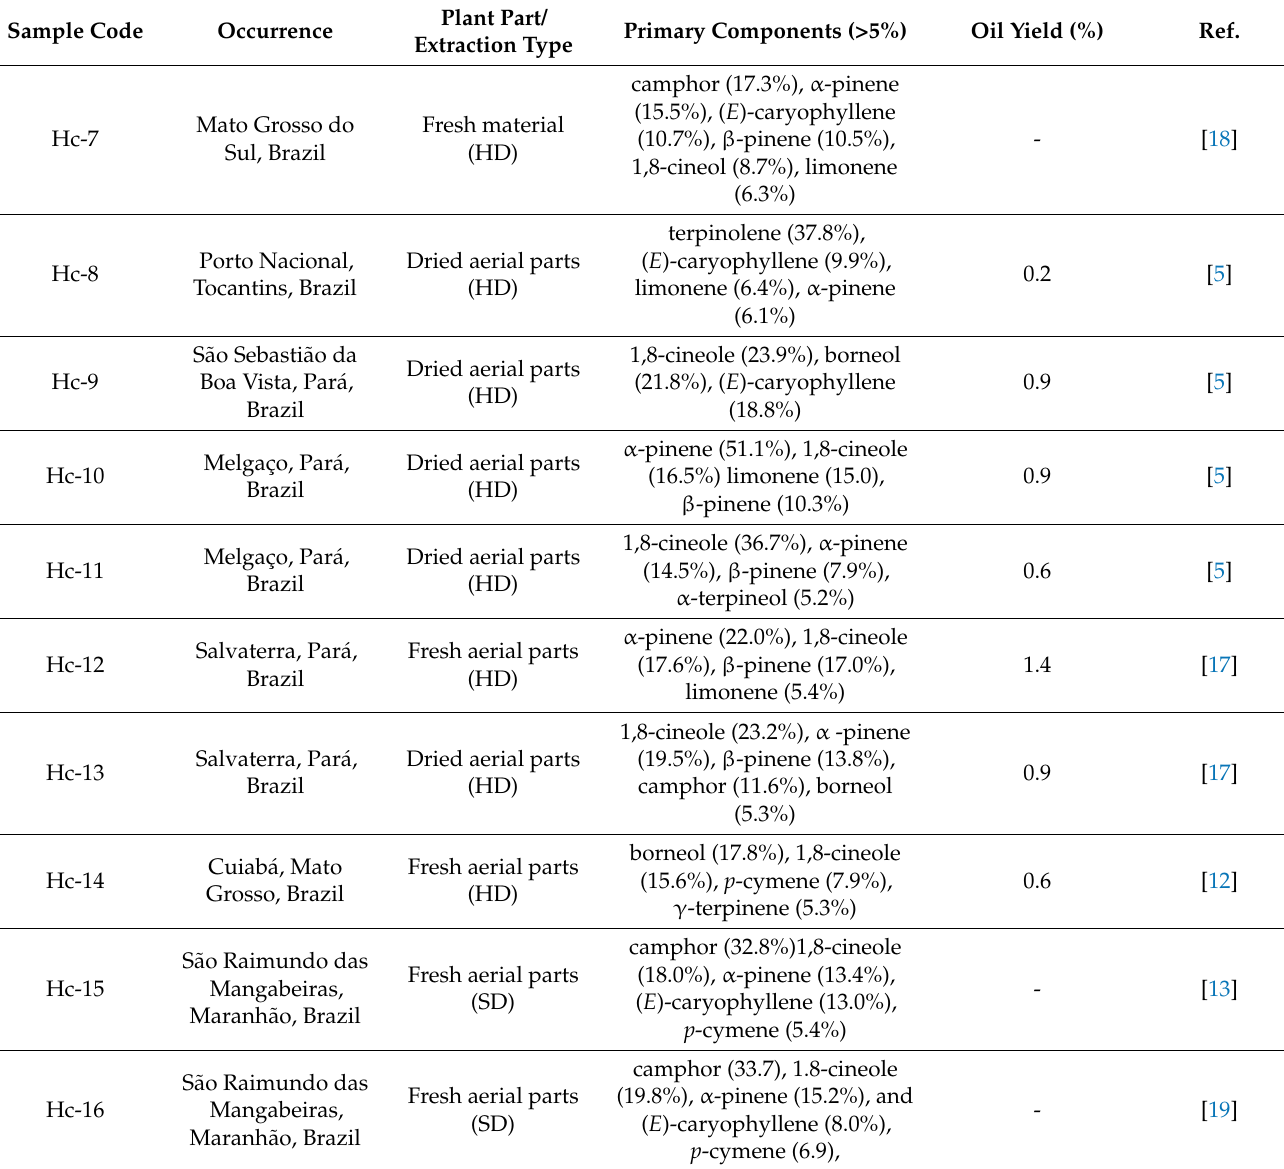
Table A1. Essential oil compositions of Hyptis crenata